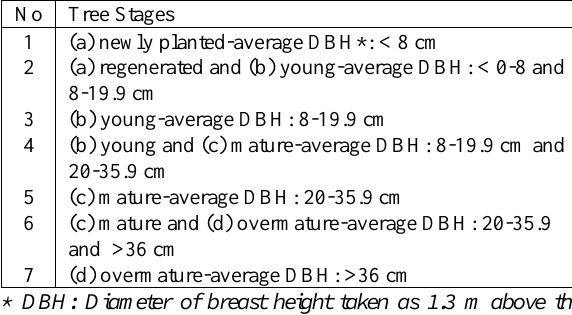
Table 4. Tree stages